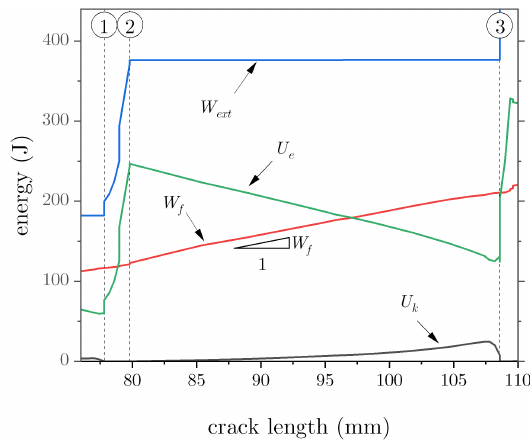
Figure 6. Energy breakdown as a function of crack